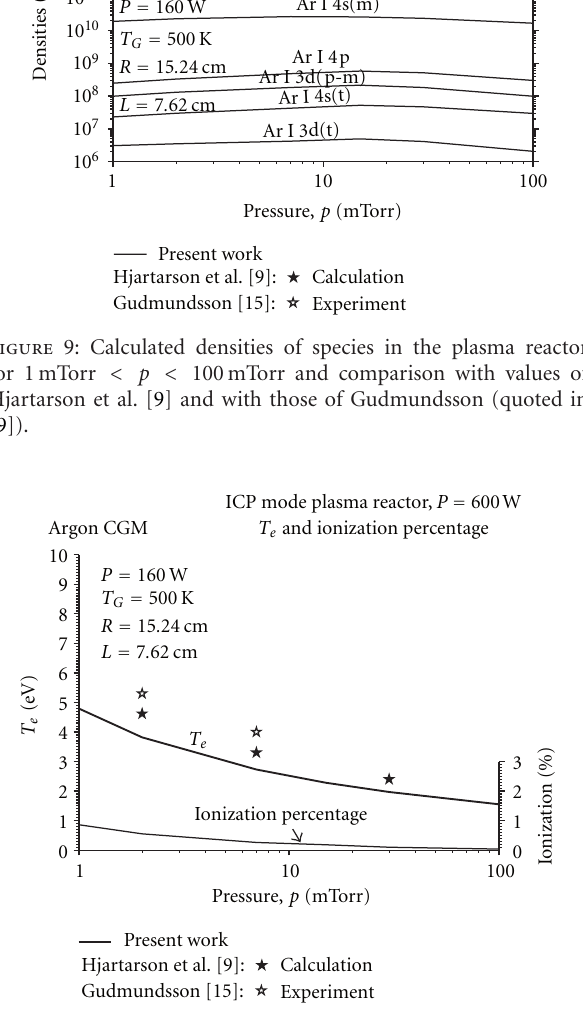
Figure 10: Calculated T e and ionization percentage in the plasma reactor for 1mTorr < p < 100 mTorr and comparison with values of Hjartarson et al. [9] and with those of Gudmundsson (quoted in [9]).